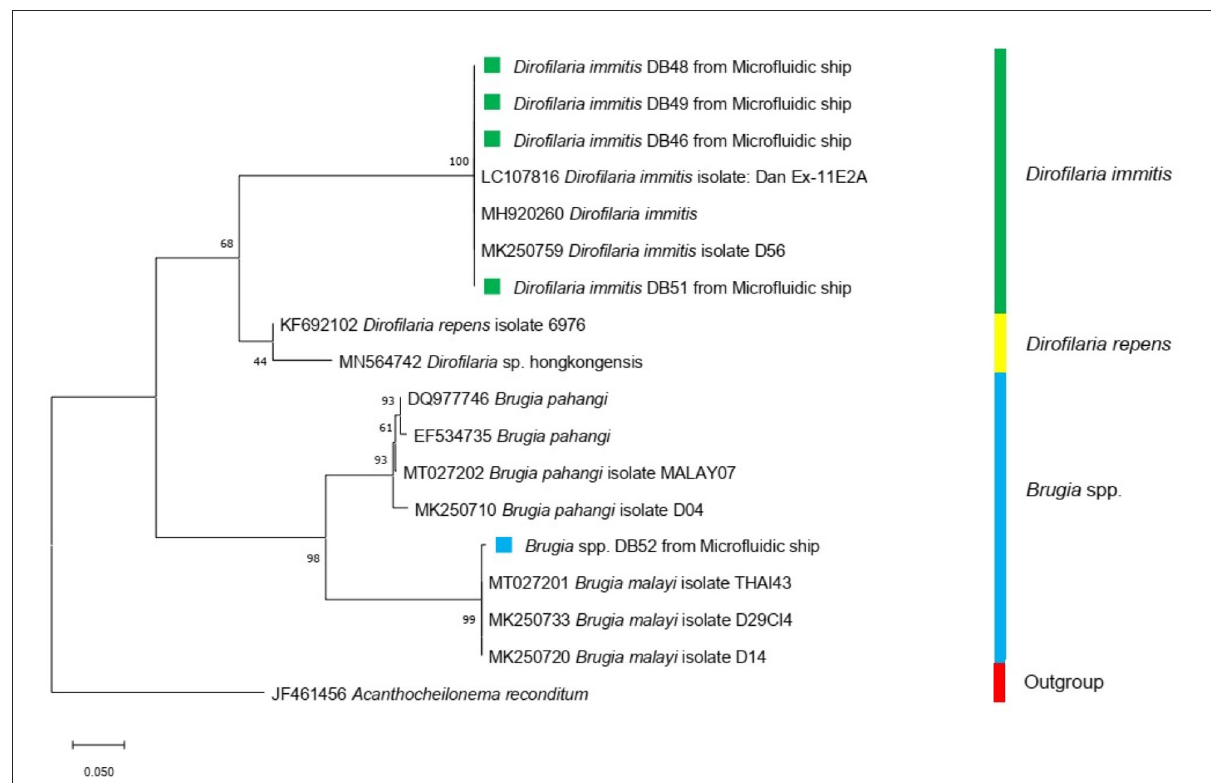
FIGURE7 Maximum-likelihood phylogenetic tree using Tamura-Nei for the substitution model disclosed the genetic relationship between Dirofilaria immitis (green square) and Brugia spp. (blue square) used in this study and other Onchocercidae nematodes based on the COI gene.